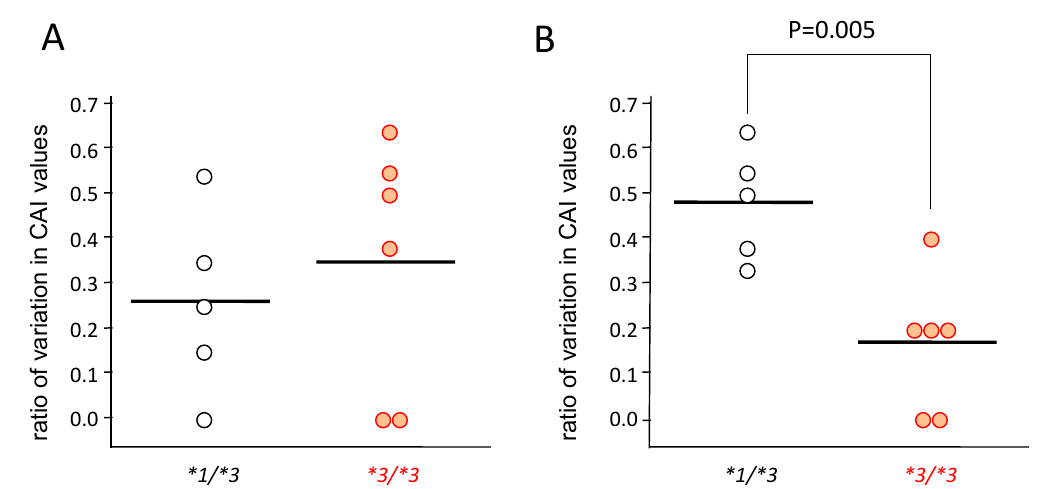
Figure 4. The rate of change in clinical activity index (CAI) in the CYP3A5 genotype after the start of tacrolimus therapy from day 0 to day 14 ( A ) and from day 14 to day 30 ( B ) . The value of vertical axis was obtained by dividing the value of difference between the CAI value at day 14 from it at day 0 by the CAI value at day 0 ((CAI at day 0–CAI at day 14)/CAI at day 0) ( A ), and by dividing the value of difference between the CAI value at day 30 from it at day 14 by that at day 14 ((CAI at day 14–CAI at day 30)/CAI at day 14) ( B ). Statistical analysis was performed using the Student’s t -test.